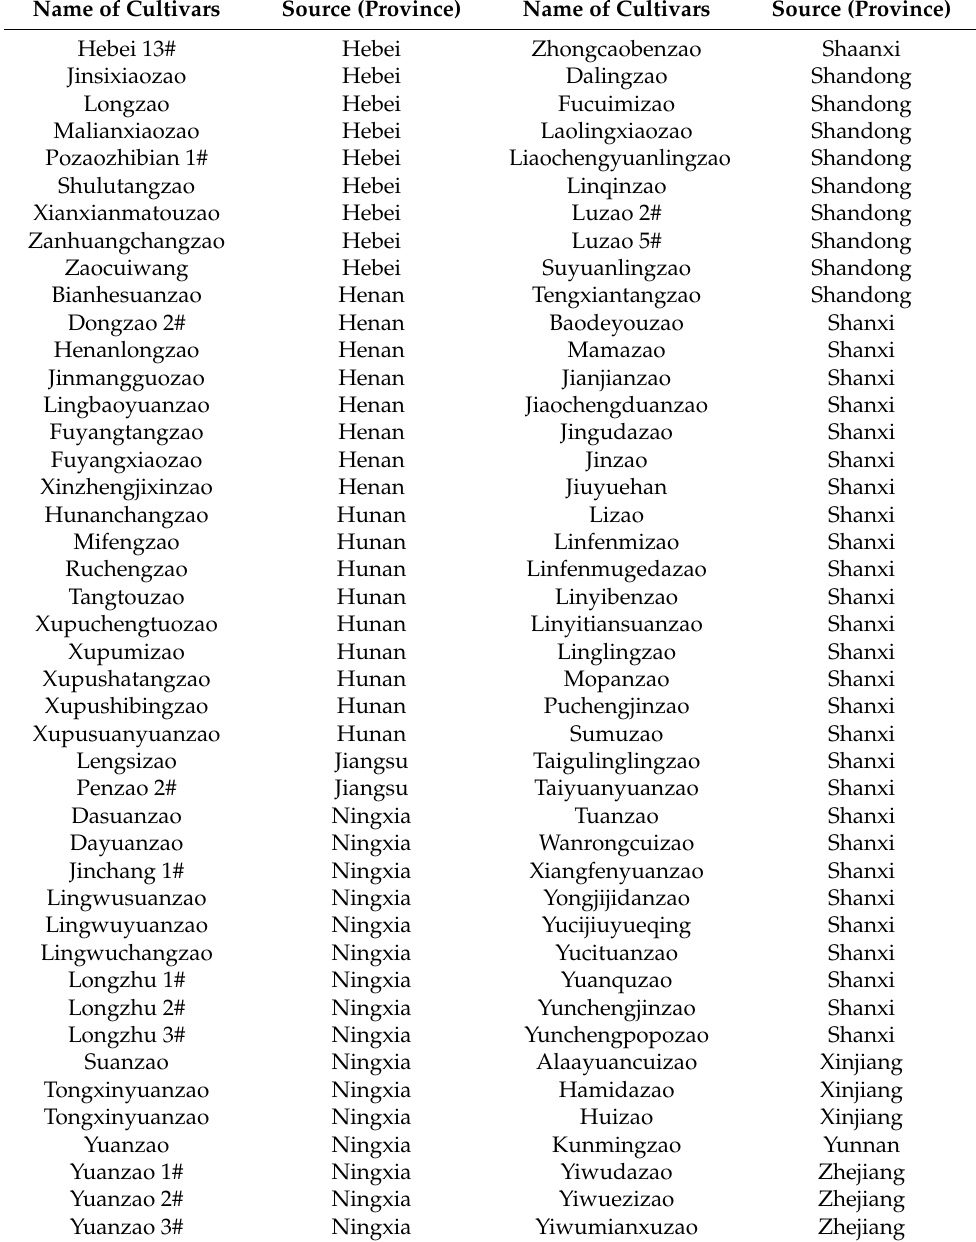
Table 1. Cont. Name of